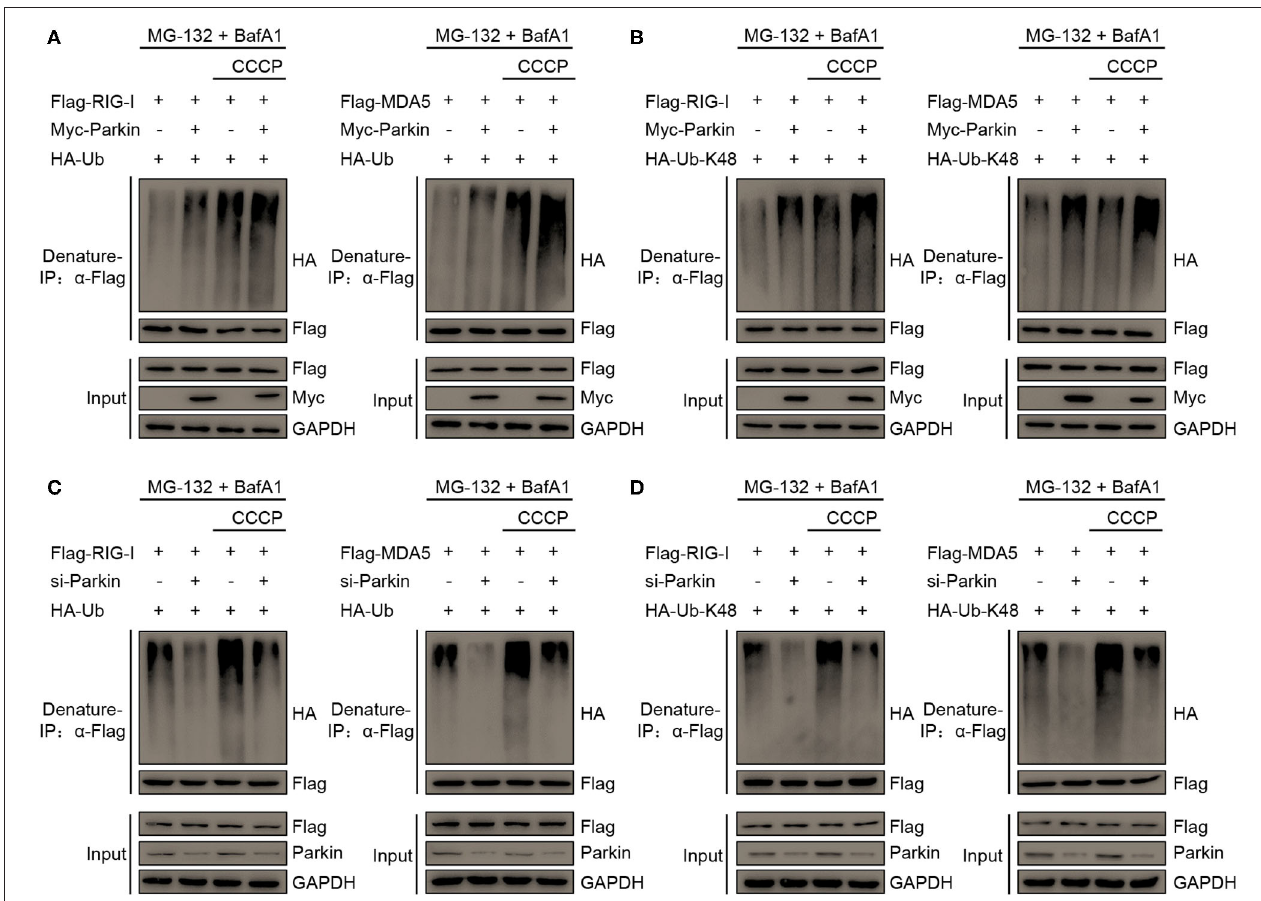
FIGURE 6 | Parkin catalyzes the K48-linked polyubiquitination of RIG-I and MDA5. (A) HA-Ubiquitin and Flag-RIG-I or Flag-MDA5 were co-transfected with vector or Myc-Parkin in 293T cells. 24h post-transfection, untreated or treated with CCCP (10 µ M) for 12h in the presence of MG-132 (10 µ M) and BafA1 (200nM) at the last 8h, and then subjected to denature-IP and IB analysis. (B) HA-Ubiquitin-K48 and Flag-RIG-I or Flag-MDA5 were co-transfected with vector or Myc-Parkin in 293T cells. 24h post-transfection, untreated or treated with CCCP (10 µ M) for 12h in the presence of MG-132 (10 µ M) and BafA1 (200nM) at the last 8h, and then subjected to denature-IP and IB analysis. (C) HA-Ubiquitin and Flag-RIG-I or Flag-MDA5 were co-transfected with si-control or si-Parkin in 293T cells. 48h post-transfection, untreated or treated with CCCP (10 µ M) for 12h in the presence of MG-132 (10 µ M) and BafA1 (200nM) at the last 8h, and then subjected to denature-IP and IB analysis. (D) HA-Ubiquitin-K48 and Flag-RIG-I or Flag-MDA5 were co-transfected with si-control or si-Parkin in 293T cells. 48h post-transfection, untreated or treated with CCCP (10 µ M) for 12h in the presence of MG-132 (10 µ M) and BafA1 (200nM) at the last 8h, and then subjected to denature-IP and IB